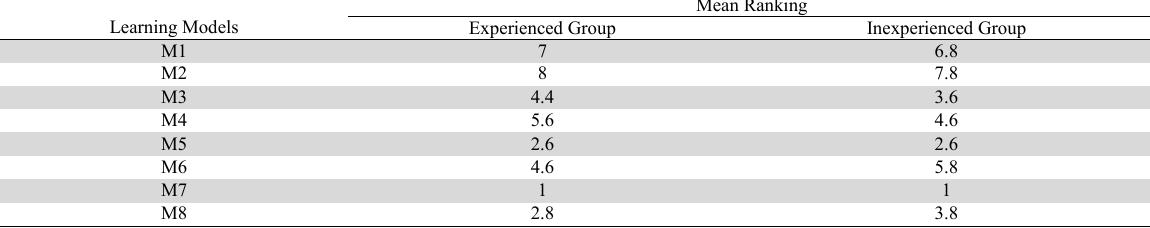
Mean ranking of models for experienced and inexperienced group (Friedman test with 7 degree of freedom) Learning Models